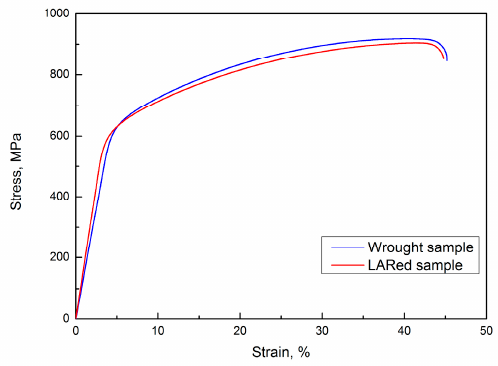
Figure 16. Typical tensile test curves of LARed sample and wrought substrate.